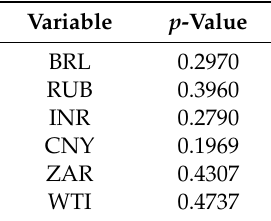
Table 3. Structural break